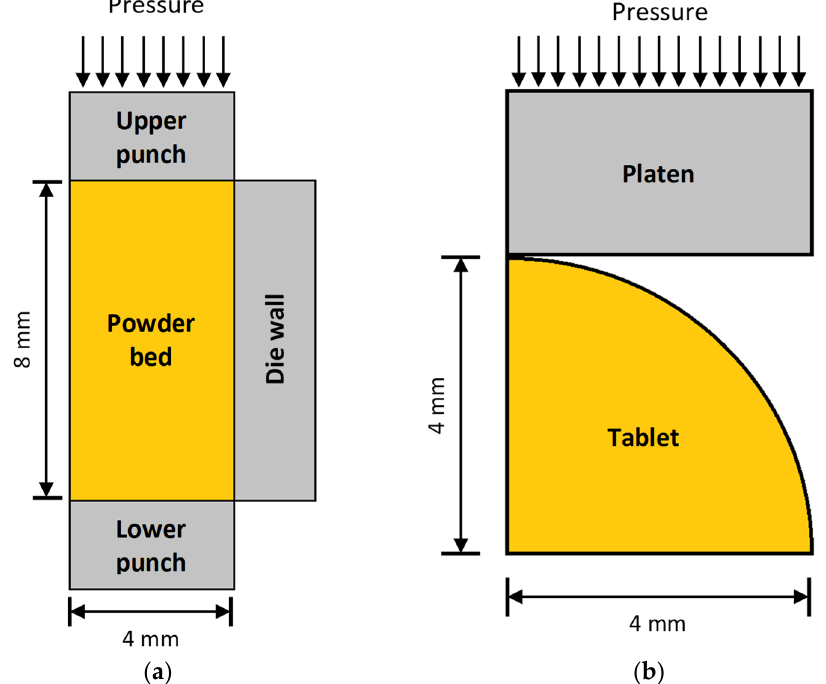
Figure 1. Symmetric geometric 2D model ( a ) for powder compression and ( b ) for diametral loading test of tablet mechanical strength.